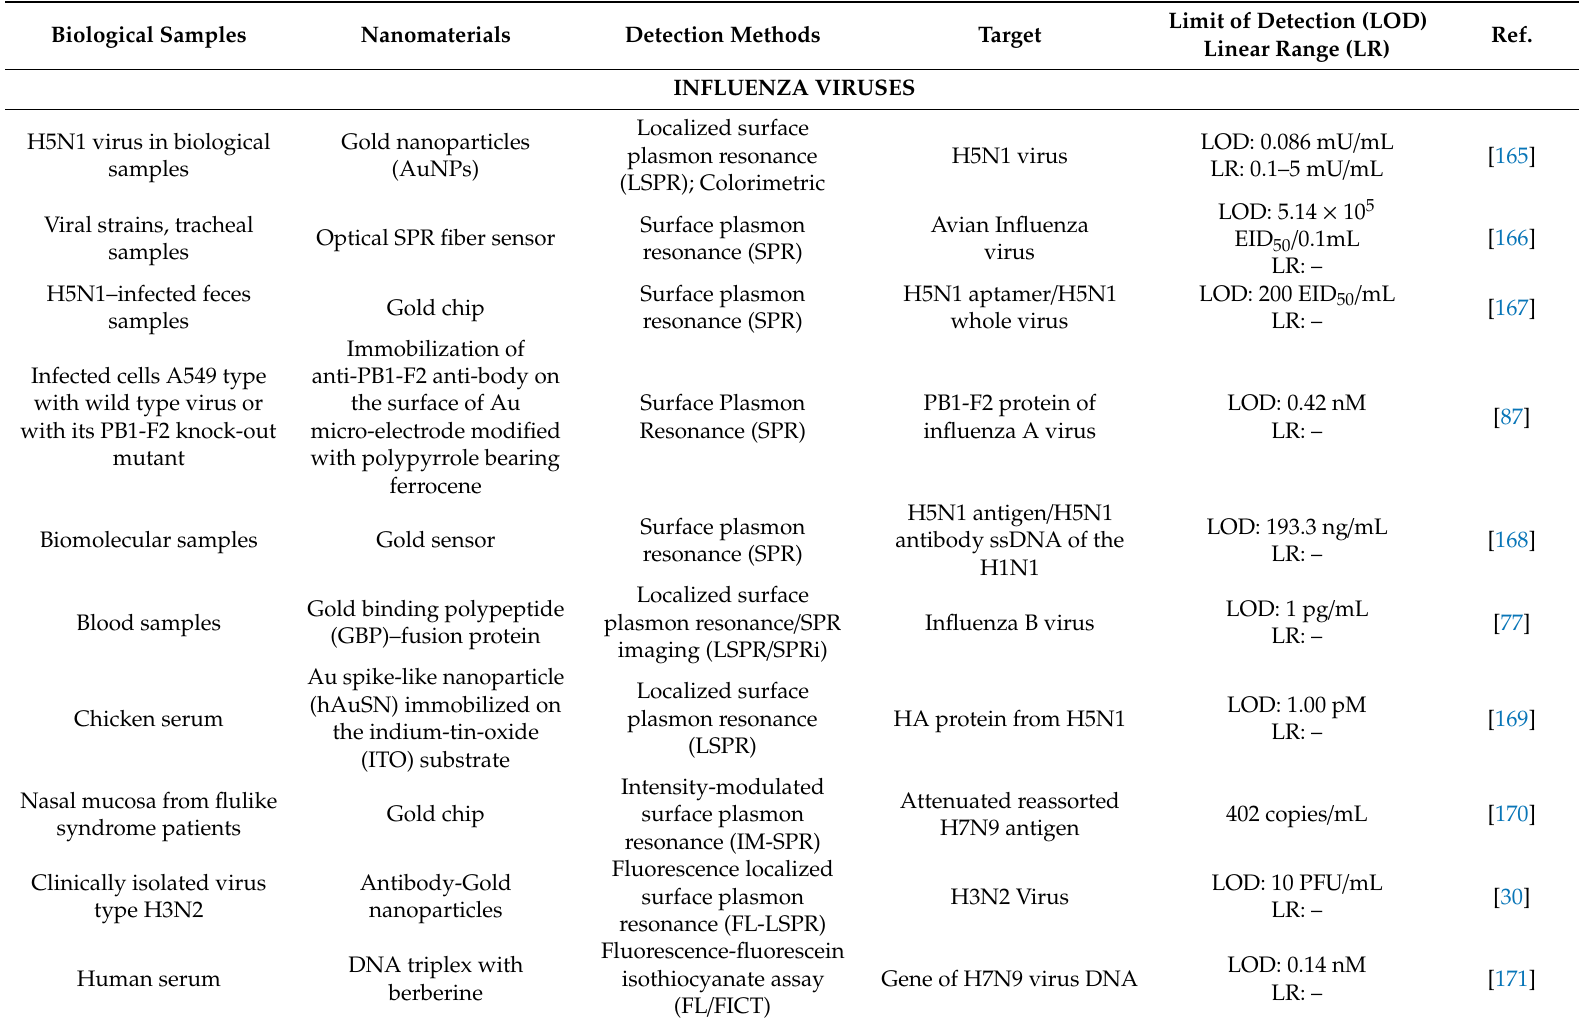
Table 4. Optical detection technique, and their properties of human coronaviruses, including recently developed 2019-nCoV nanobiosensors and influenza